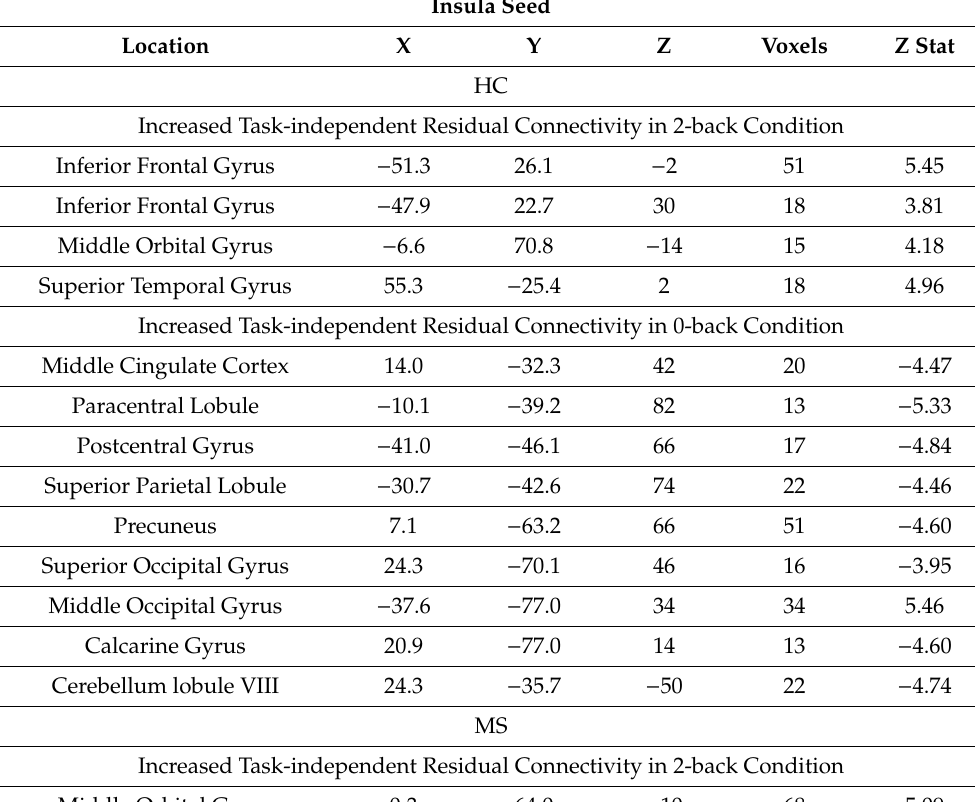
Table 6. Task-independent (residual) fatigue-related functional connectivity with the insula as seed. Insula